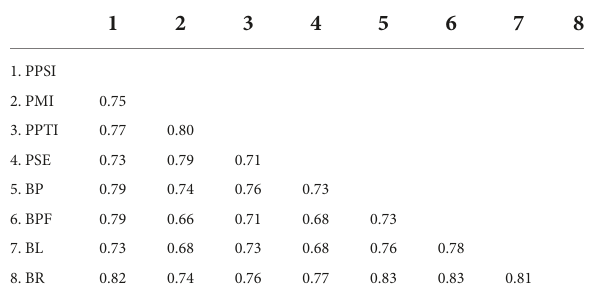
TABLE 4 Heterotrait monotrait analysis.